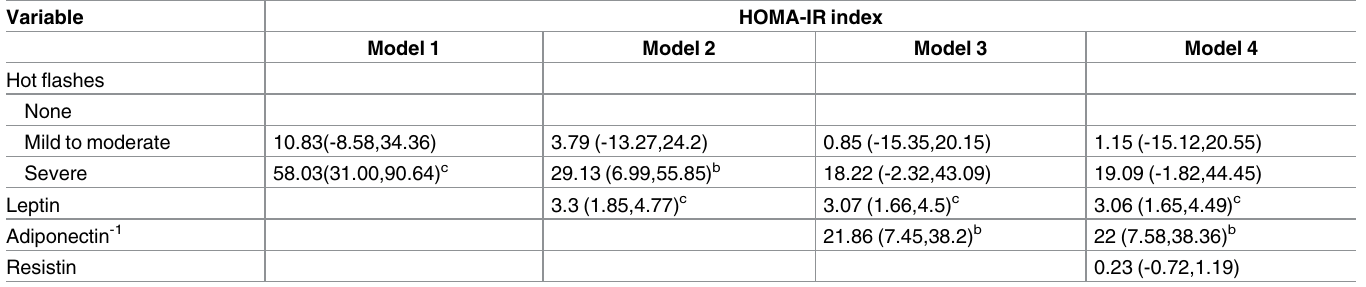
Table 3. Association of HOMA-IR index with hot flash status and adipocyte-derived